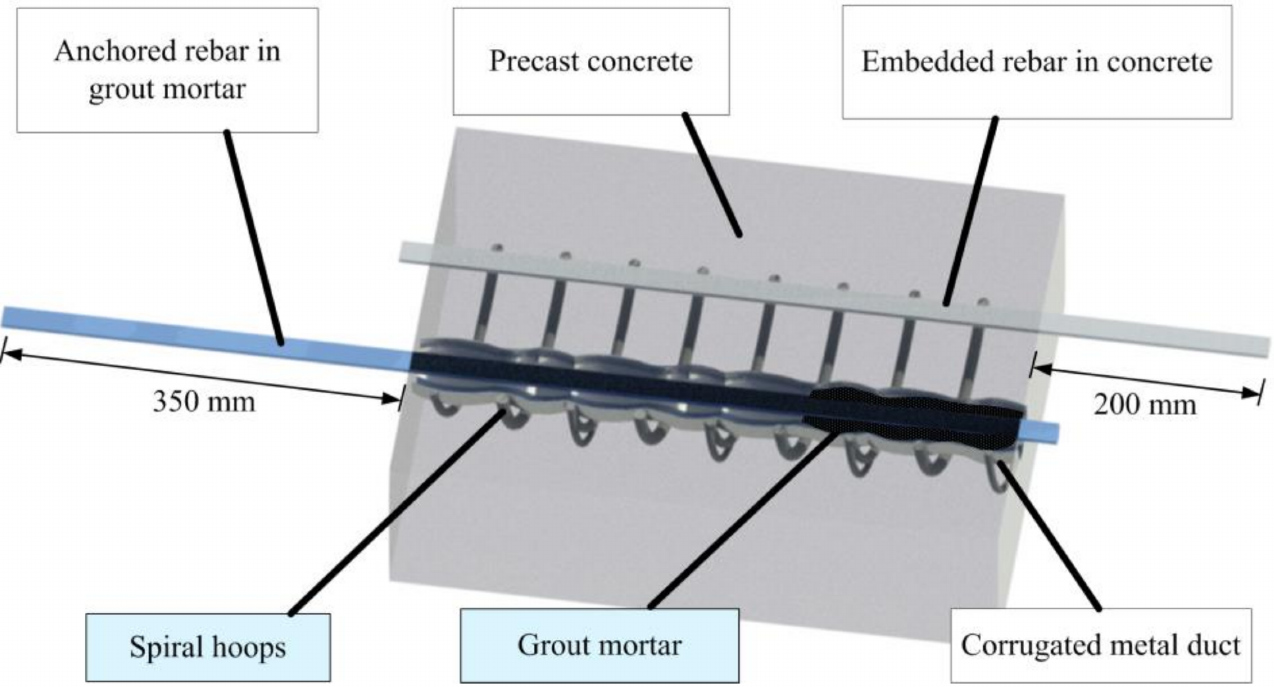
Figure 3. The short-lapped-rebar